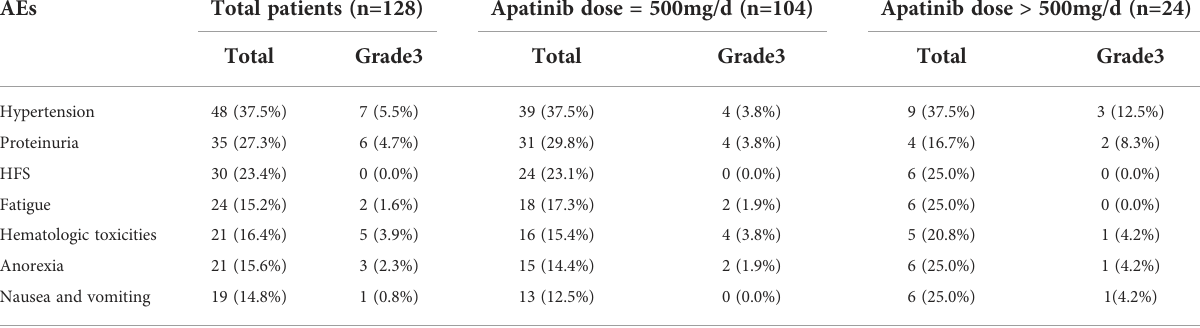
TABLE 4 Treatment-related AEs in patients with advanced